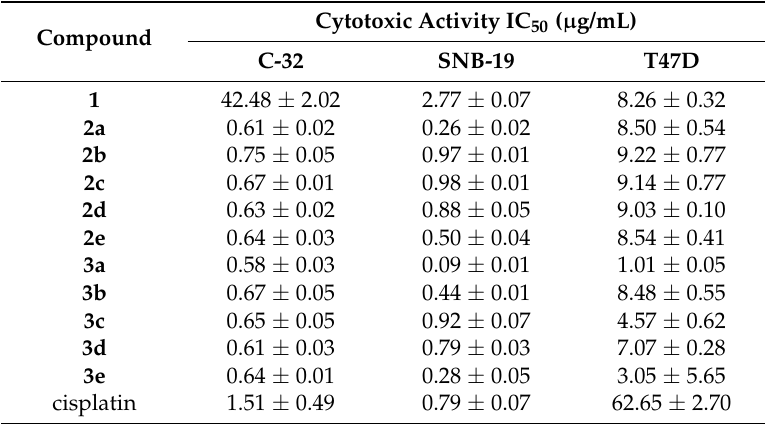
Table 4. Cytotoxic activity of 6,7-dichloro-5,8-quinolinedione 1 , amine derivatives of 5,8-quinolinedione 2 – 3 and cisplatin as a reference